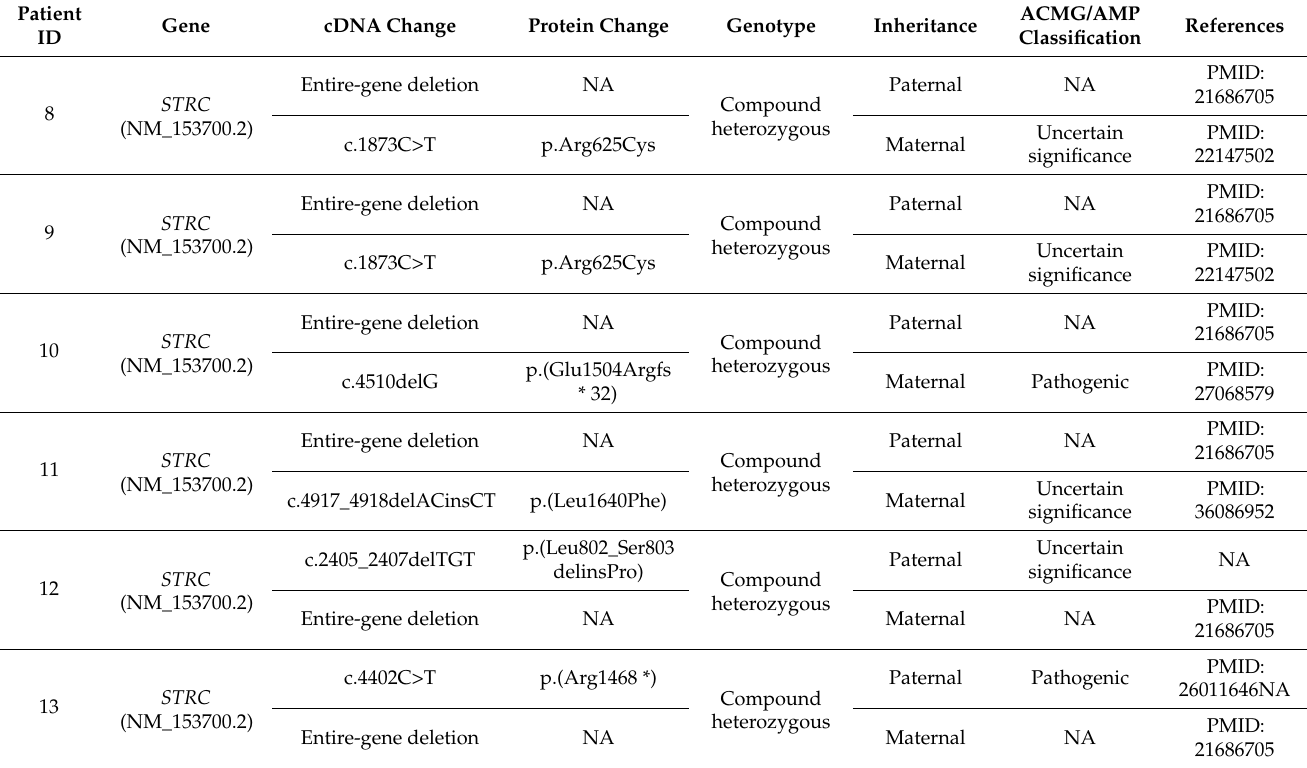
Table 2. STRC deletions and SNVs identified in the six patients that underwent both MLPA and LR-PCR analyses. Gene: gene carrying the deletion or the identified variants with NCBI RefSeq accession number of the considered protein-coding transcripts (NM_). cDNA change and Protein change: variant description according to the Human Genome Variation Society (HGVS)